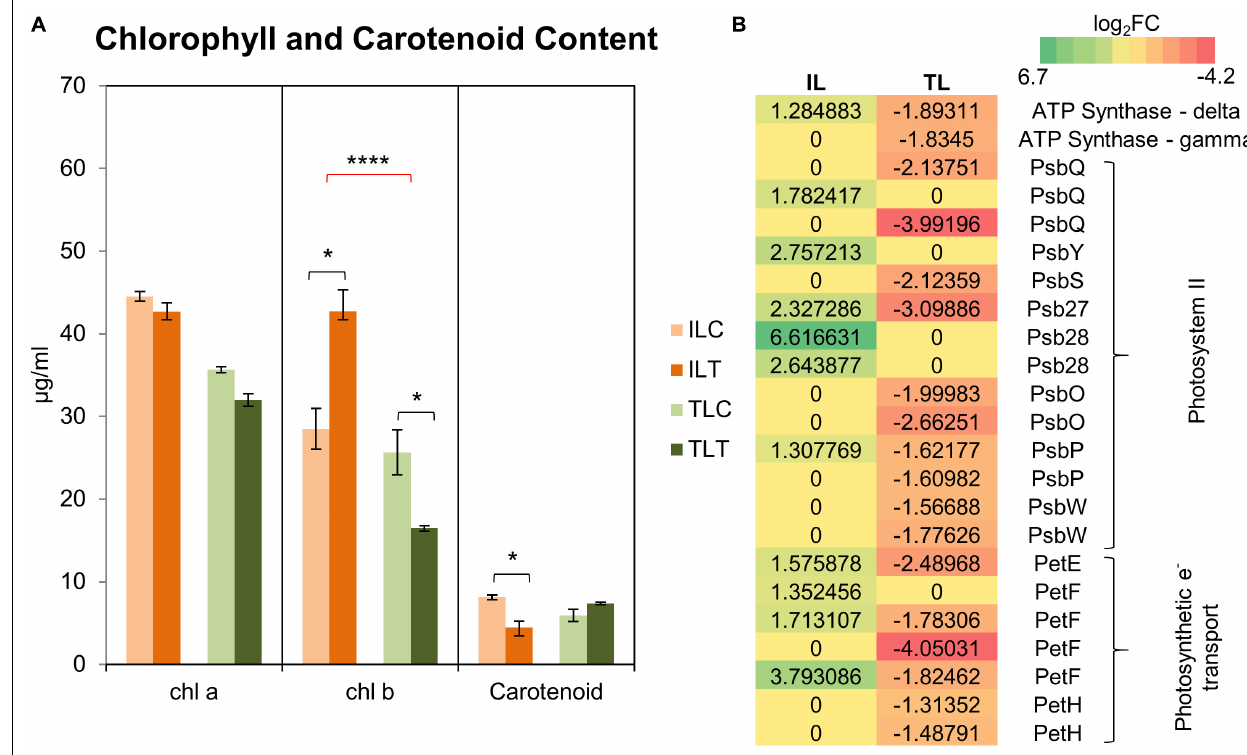
FIGURE 4 | Chlorophyll and carotenoid content changes in the leaf tissues (A) . “C” depicts control condition and “T” depicts treatment condition. Heatmap with log 2 -fold changes of photosynthesis-related transcripts in KEGG pathways (B) . A more comprehensive table can be found at Additional File 3 . * indicates significance and quantity of * displays the level of significance. (* p < 0.05; ** p < 0.01; *** p < 0.005; **** p < 0.001).